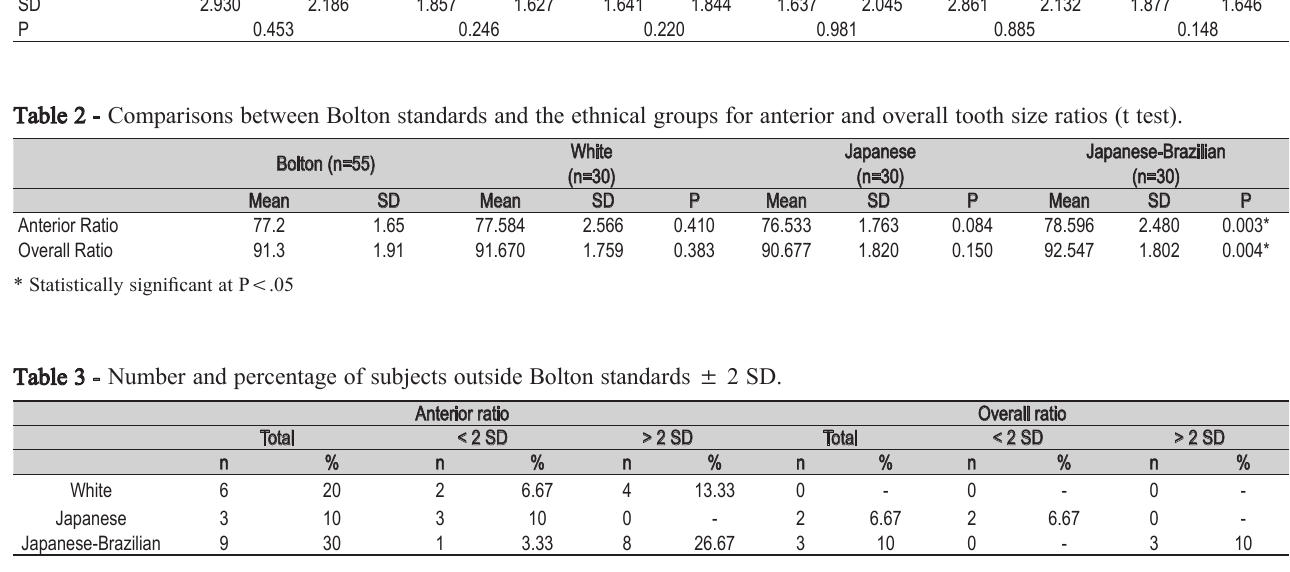
Table 2 - Comparisons between Bolton standards and the ethnical groups for anterior and overall tooth size ratios (t test).